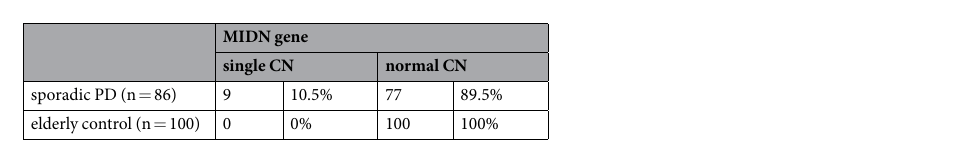
Table 1. MIDN copy number analysis in patients with sporadic PD and elderly normal controls. The MIDN gene copy numbers (CN) in 86 sporadic PD patients and 100 elderly controls were analyzed as described in Methods. There was significant MIDN copy number variation between sporadic PD patients and controls, with 10.5% patients possessing only a single copy of the MIDN gene, compared to no gene loss in healthy controls ( p <